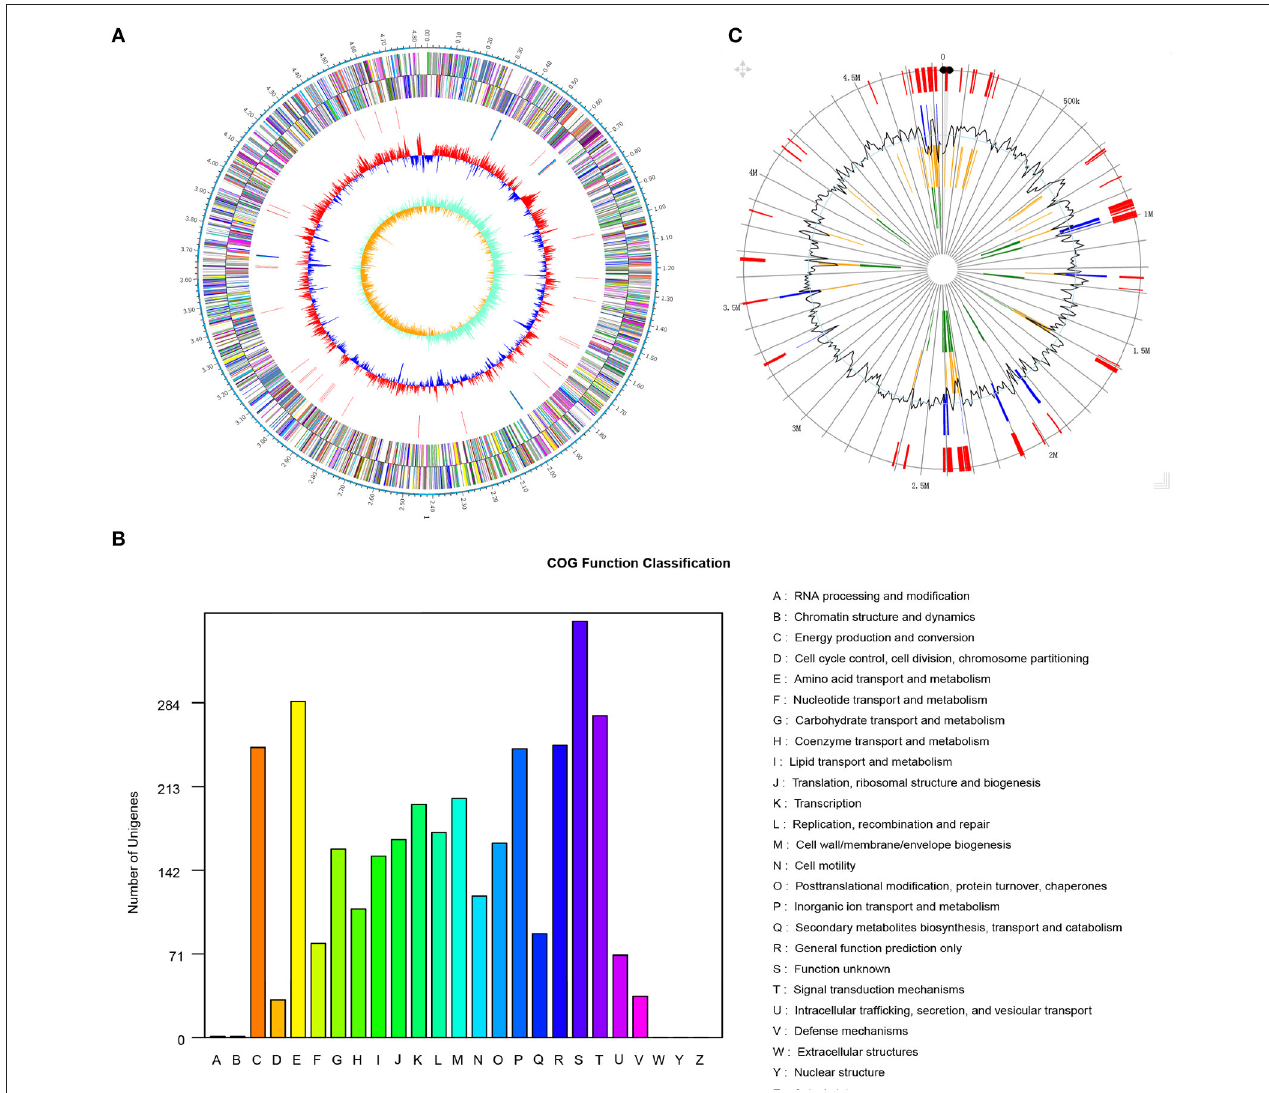
FIGURE 2 | Genome features of Pseudomonas sp. strain SI-3. (A) Graphical map of chromosome of Pseudomonas sp. strain SI-3. The outer scale is marked in 0.1Mb. From the outside to the center of each circle: Circle 1 and 2, genes encoded on forward and reverse strands, respectively. Coding sequences are colored by COG categories. Circle 3, RNA genes. Circle 4, GC content. Circle 5, GC skew (G–C/G + C). (B) COG function classification of SI-3. The ordinate axis indicates the gene numbers in each COG functional category. (C) Genomic islands predicted by two methods. Blue lines present the genomic islands predicted by IslandPATH-DIMOB method. Yellow lines present the genomic islands predicted by SIGI-HMM method. Red lines present the integrated genomic islands predicted by two methods. The second circle indicates the GC